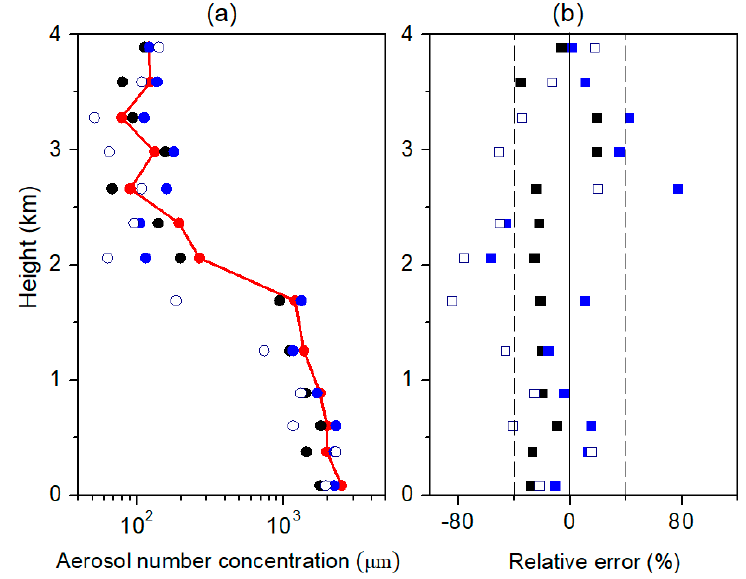
Figure 10. ( a ) Measured aerosol number concentration, inversion number concentration and ( b ) the corresponding relative error at the vertical heights.